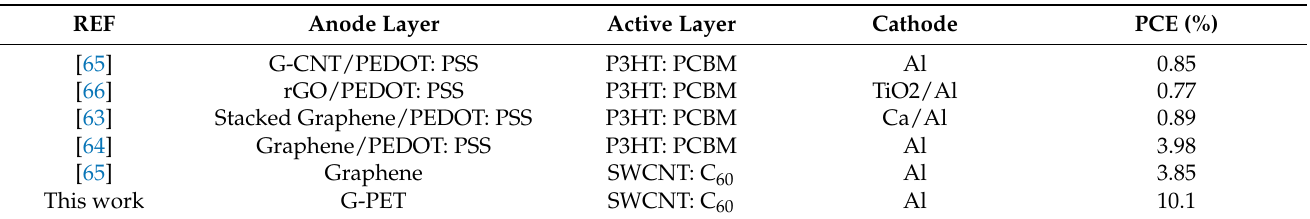
Table 6. Summary of graphene-based electrodes having the best PCEs employing them in OPV